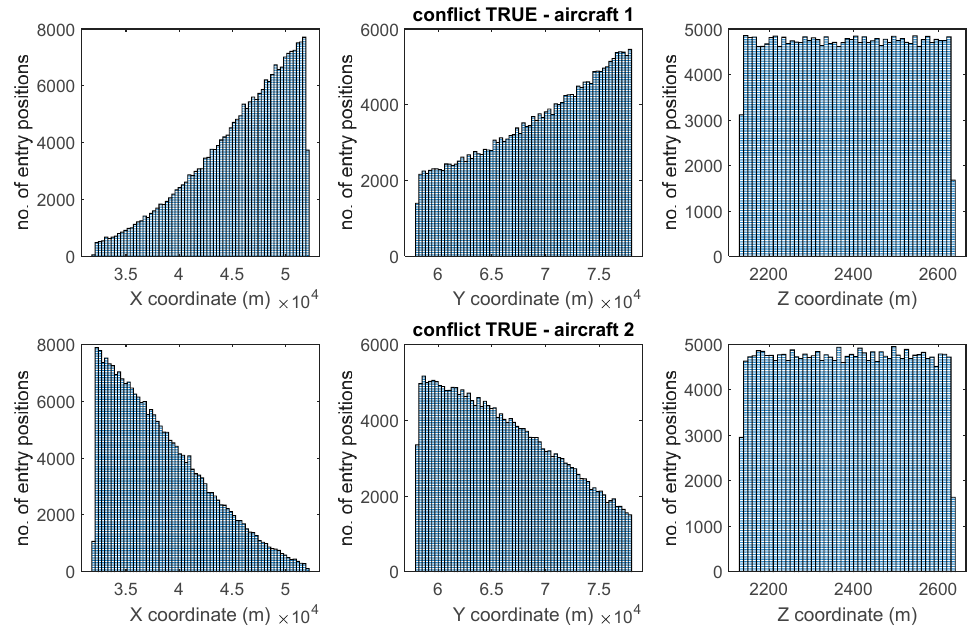
Figure 8. Entry positions distribution of conflicting pairs of aircraft.